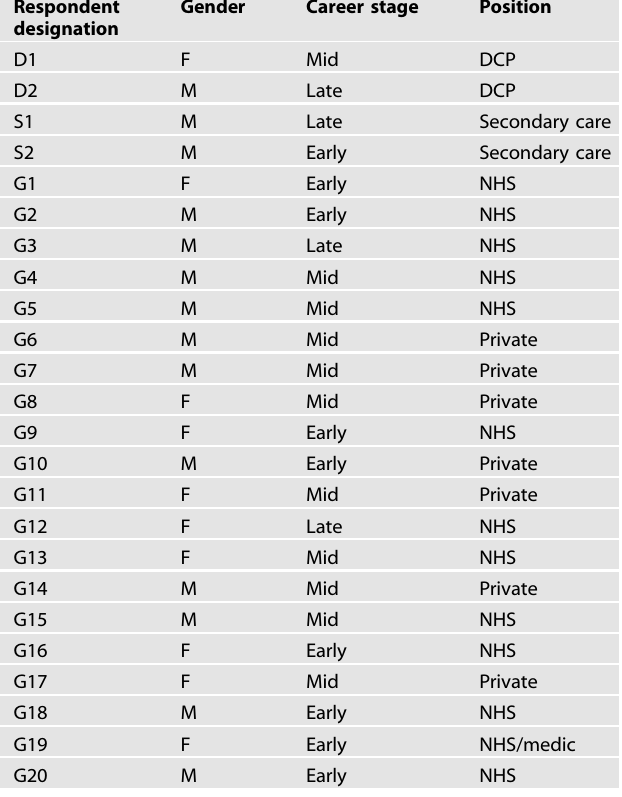
Table 1. Respondent